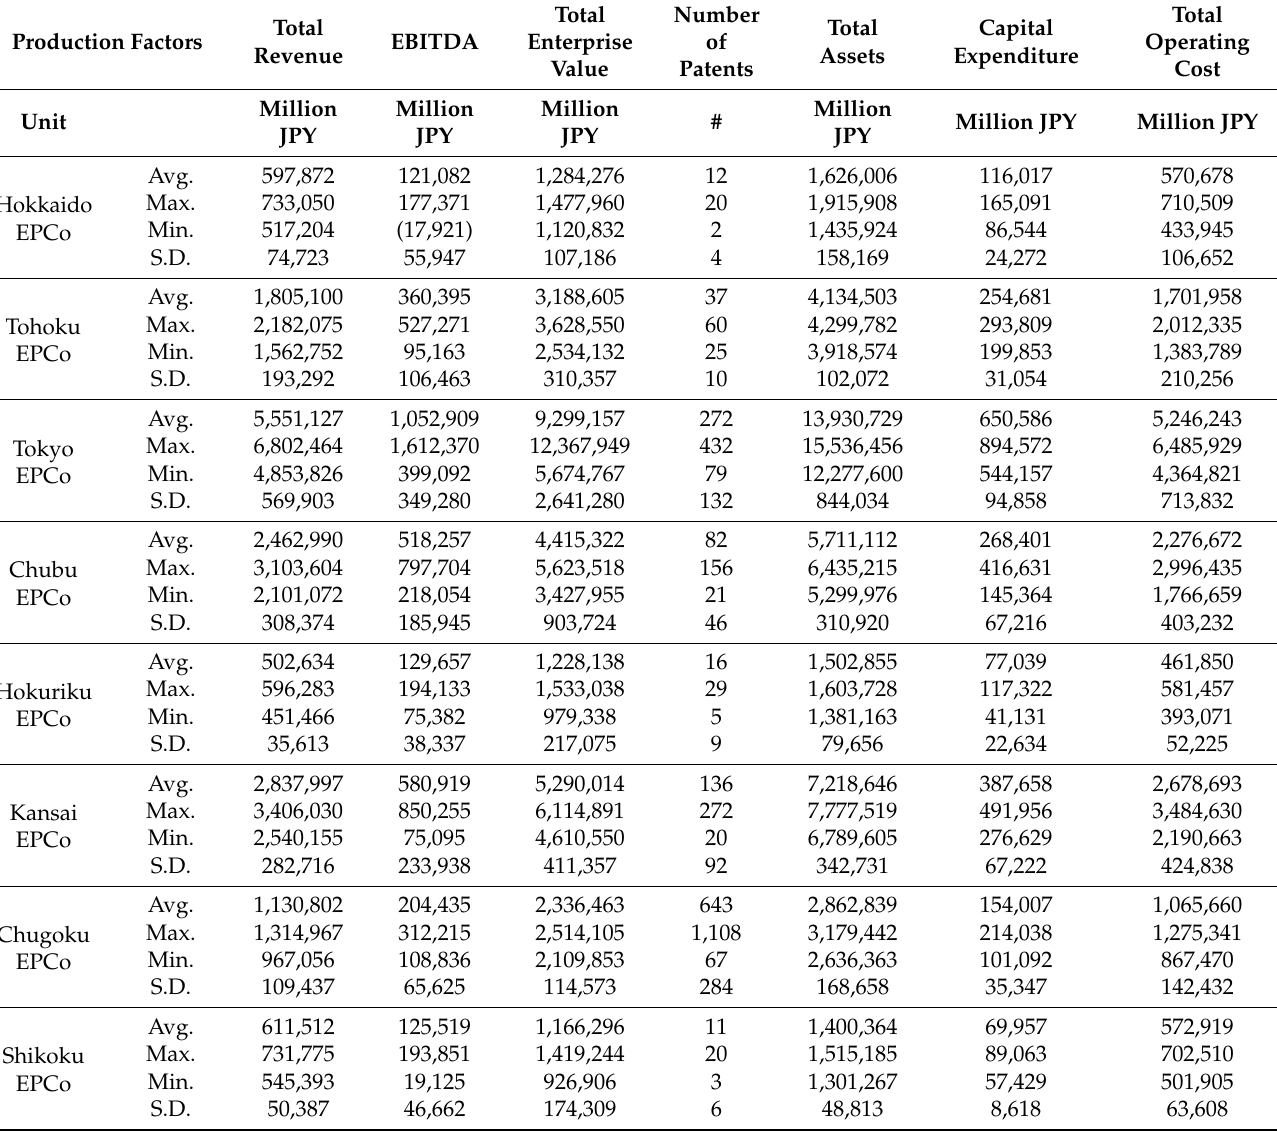
Table 1. Descriptive Statistics